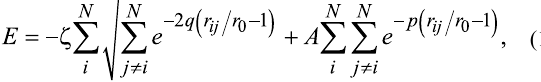
Figure 2: (a) Atomically flat Au(111) surface with herringbone recon- struction and straight step edges in crystallographic directions (i.e., , and ) prepared by stress-induced lattice deforma- tions at low temperatures, (b) Gold adatoms deposited on a Au(111) surface from the STM tip. Images obtained at about 3 K after the tem- perature was stabilized within a few